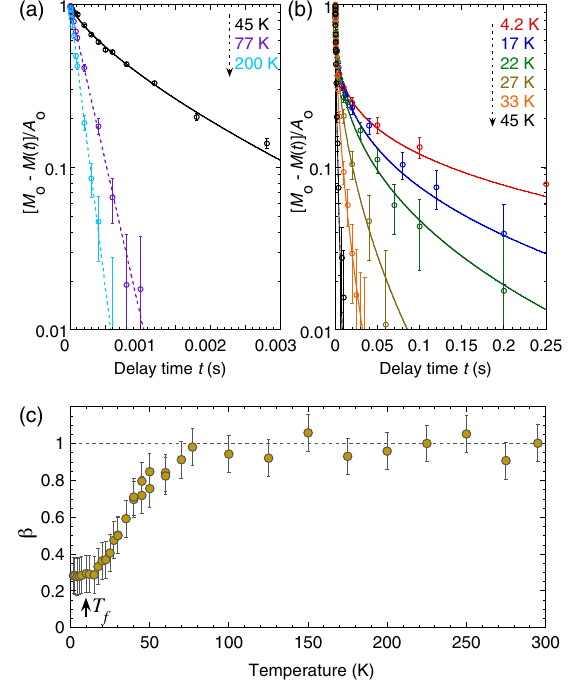
FIG. 13. (a),(b) The 63 Cu NQR T 1 recovery curves observed at representative temperatures for the Cu ð I 1 Þ sites, presented in the form of ½ M o − M ð t Þ(cid:4) =A . Dashed straight lines are the best exponential fit with Eq. (A1), while the solid curves are the best phenomenological stretched exponential fit with Eq. (A2). (c) The stretched exponent β obtained from the fit with Eq. (A2) choosing β as a free